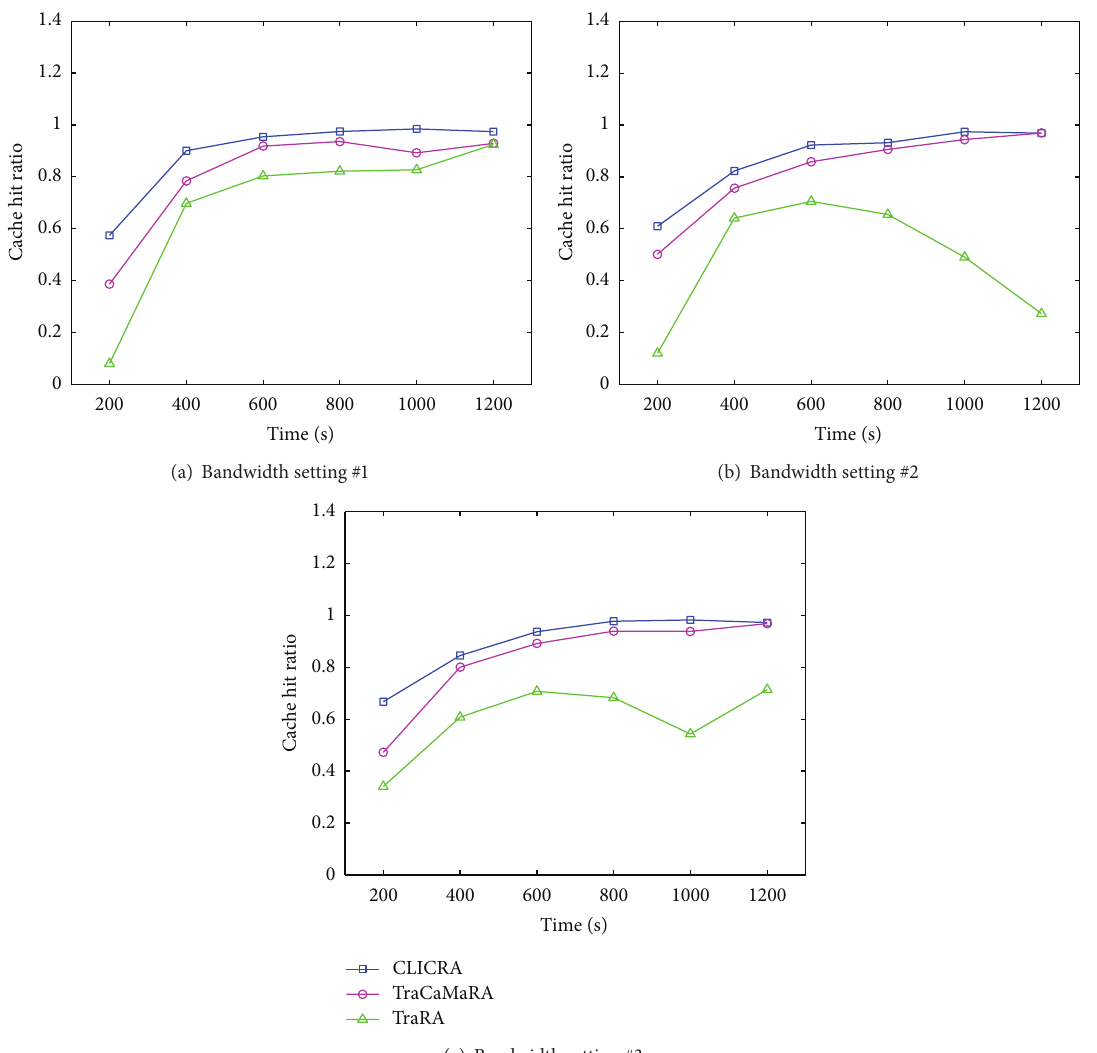
Figure 7: Average cache hit ratio of the clients over simulation time for receive window 1000 Kbytes.